Question: What style of plot is this figure drawn as?
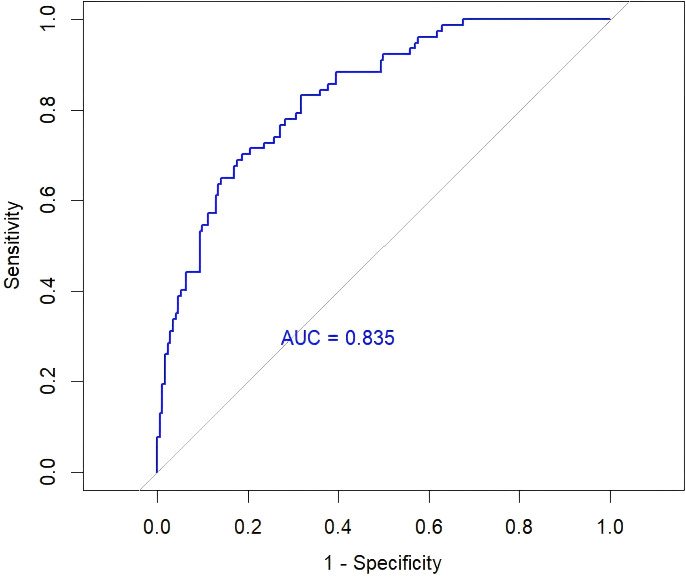
Answer: line